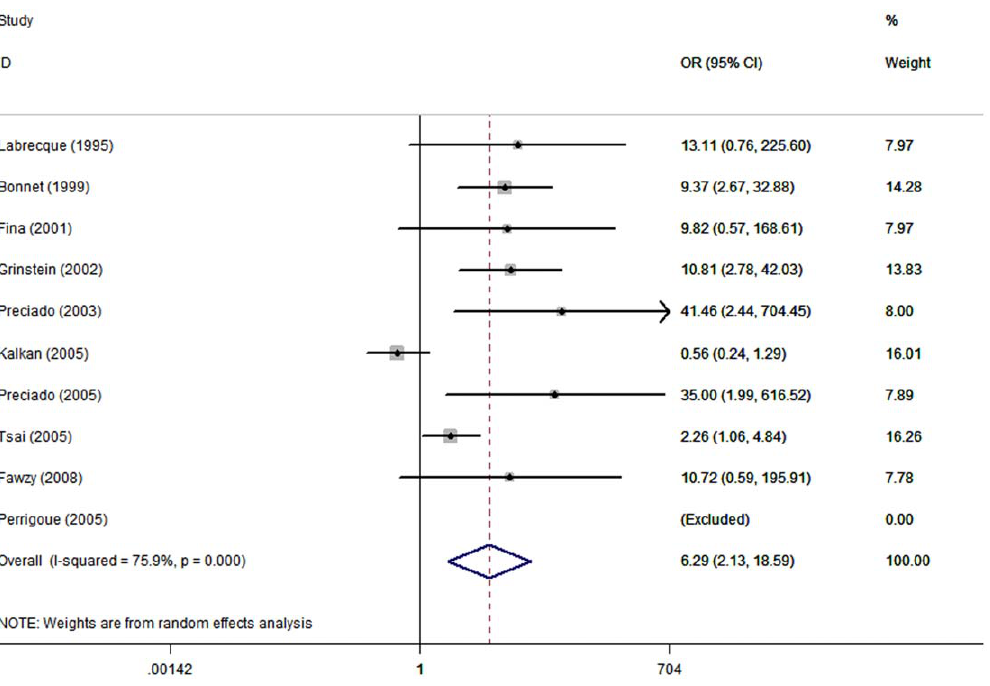
Paired data of amplification fragments